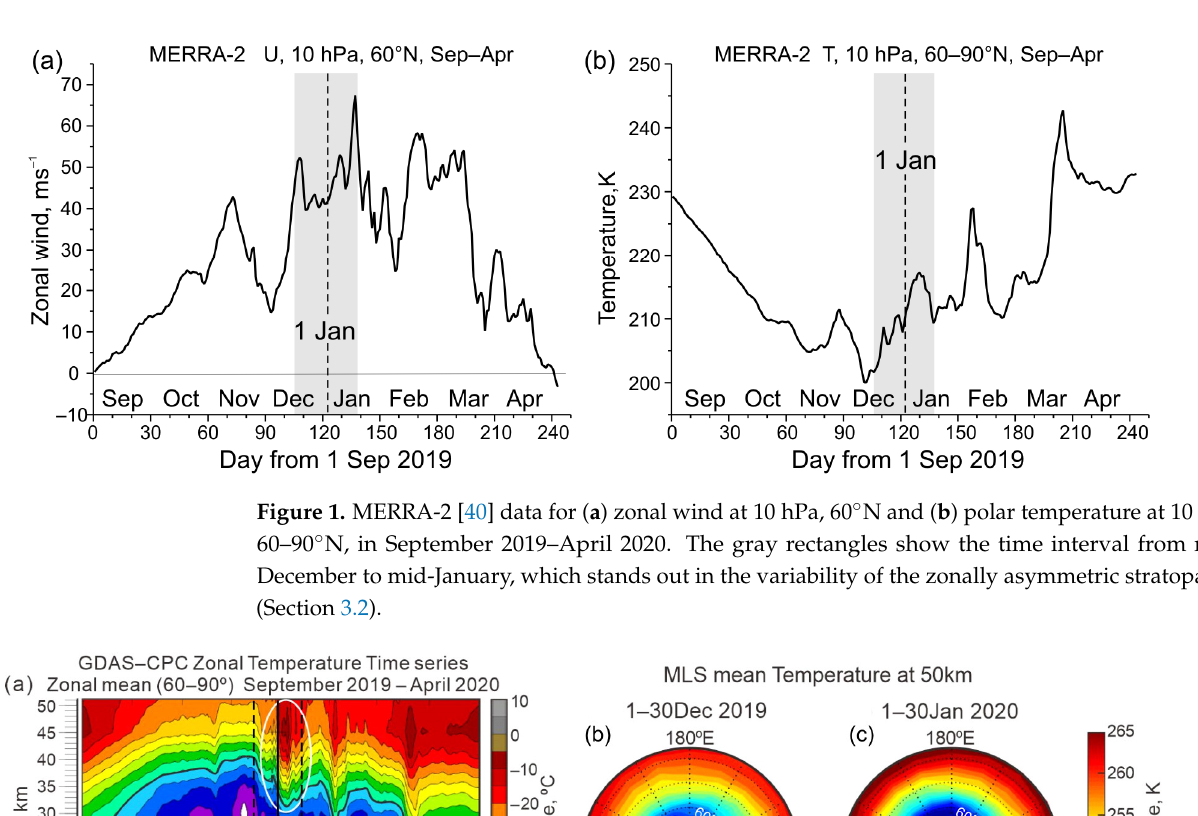
Figure 1. MERRA-2 [40] data for ( a ) zonal wind at 10 hPa, 60 ° N and ( b ) polar temperature at 10 hPa, 60–90 ° N, in September 2019–April 2020. The gray rectangles show the time interval from mid- December to mid-January, which stands out in the variability of the zonally asymmetric stratopause (Section